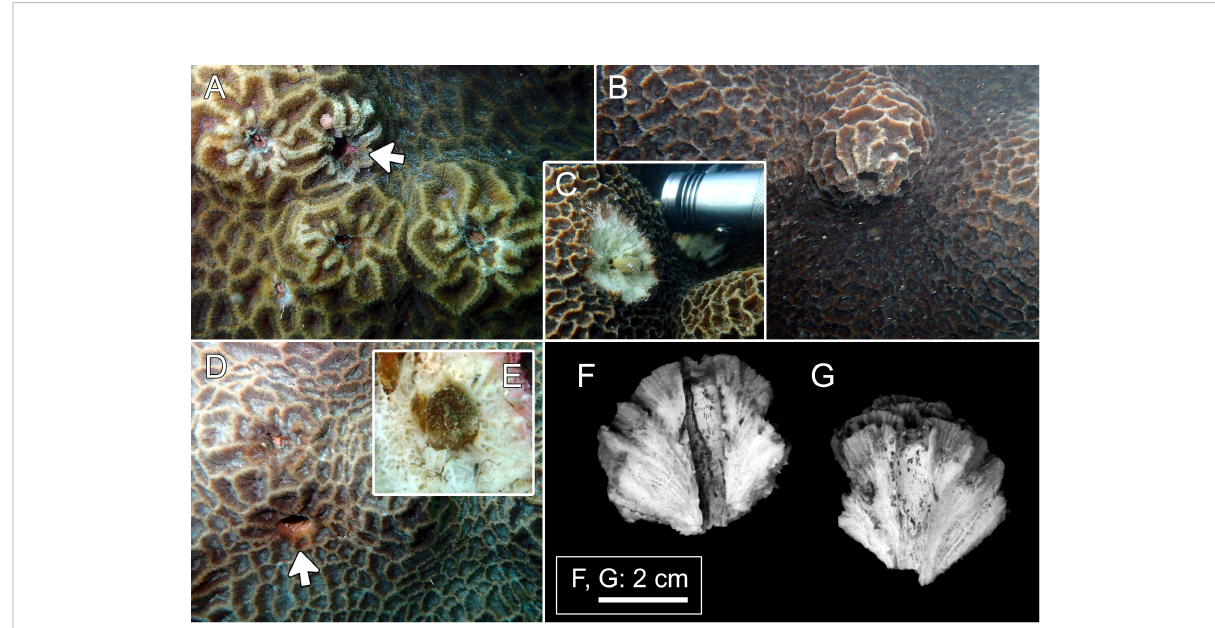
FIGURE 2 Host and domicile of Lithoscaptus paradoxus . (A) Platygyra contorta , Long Ke Tsai; (B, C) P. acuta , Tai She Wan; (D, E) , P. acuta , Long Ke Tsai. Insets (C, E) showing retrieved crabs. Arrows in panels (A, D) showing openings of domiciles. Cross-section of domicile: (F, G) Bluff Island.